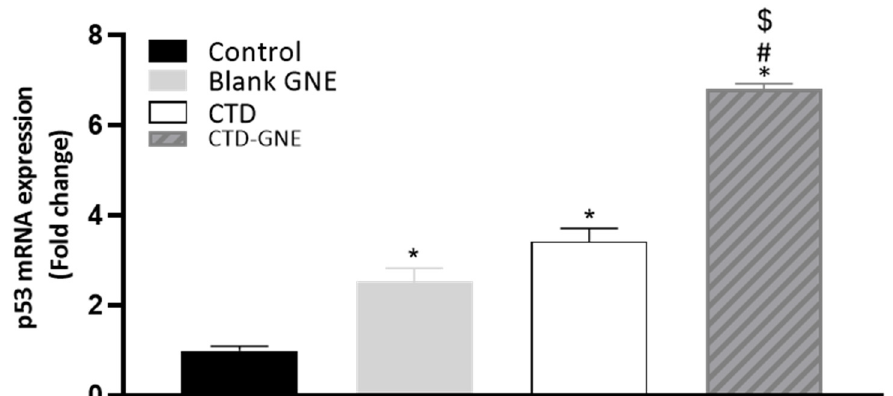
Figure 8. Effect of blank GNE, CTD raw, or CTD-GNE treatments on p53 mRNA expression in A549 cells. All data are expressed as the mean ± SE of three independent experiments. * p < 0.05 is considered significantly different from the control, # p < 0.05 is considered significantly different from blank GNE, and $ p < 0.05 is considered significantly different from CTD.